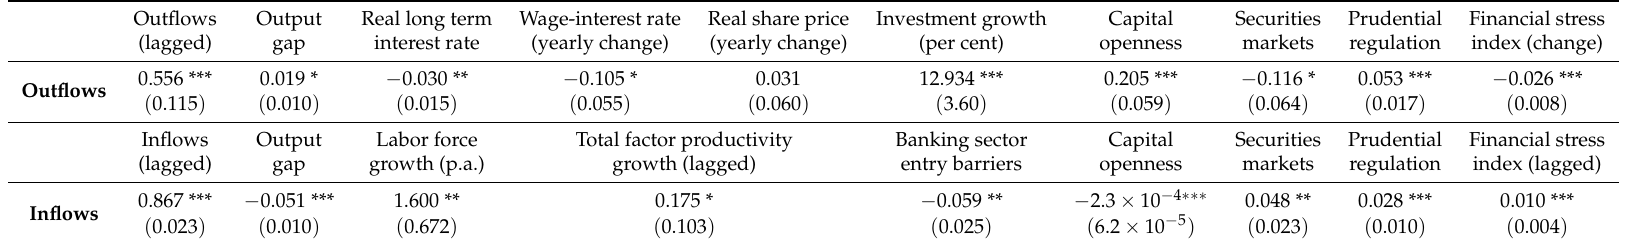
Table 8. Scenario